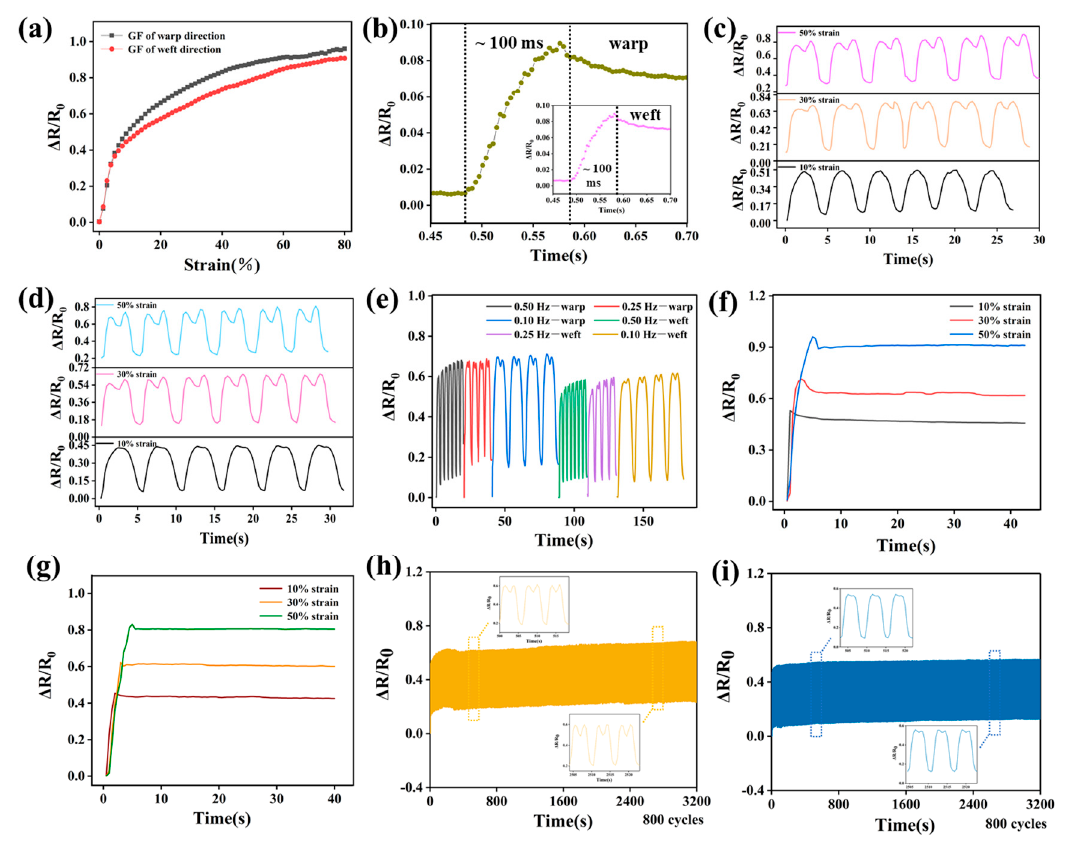
Figure 6. Strain sensing performance of the DEF/c-MWCNTs/PPy sensor. ( a ) Plots of RRV versus strain for DEF/c- MWCNTs/PPy sensor. ( b ) Response time of the DEF/c-MWCNTs/PPy sensor at a quasi-transient step strain of 1%. The RRV of the DEF/c-MWCNTs/PPy sensor under strains (10, 30, and 50%) at the frequency of 0.20 Hz: ( c ) warp sensor and ( d ) weft sensor. ( e ) The RRV of the warp and weft DEF/c-MWCNTs/PPy sensor at different frequencies (0.50, 0.25, and 0.10 Hz) under 20% strain. The RRV of the DEF/c-MWCNTs/PPy sensor for a step strain from 0 to 10%, 30 and 50% (strain rate 10% s-1): ( f ) warp sensor and ( g ) weft sensor. The stretching–releasing tests under a cyclic strain of 20% at 0.25 Hz for 800 cycles of ( h ) warp sensor and ( i ) weft sensor.